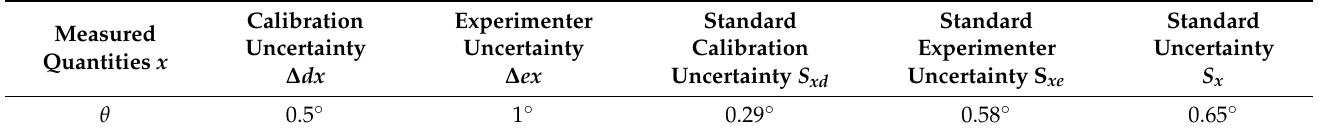
Table 3. Uncertainty of angle θ measurements on the laboratory